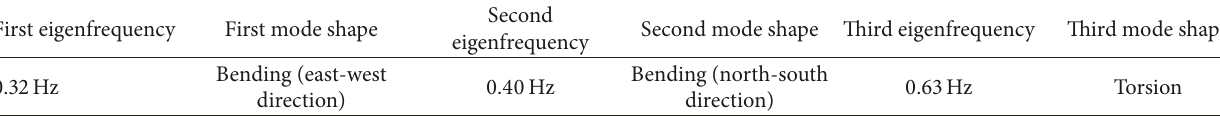
Table 1: Reference parameters for the Monte Carlo simulations.